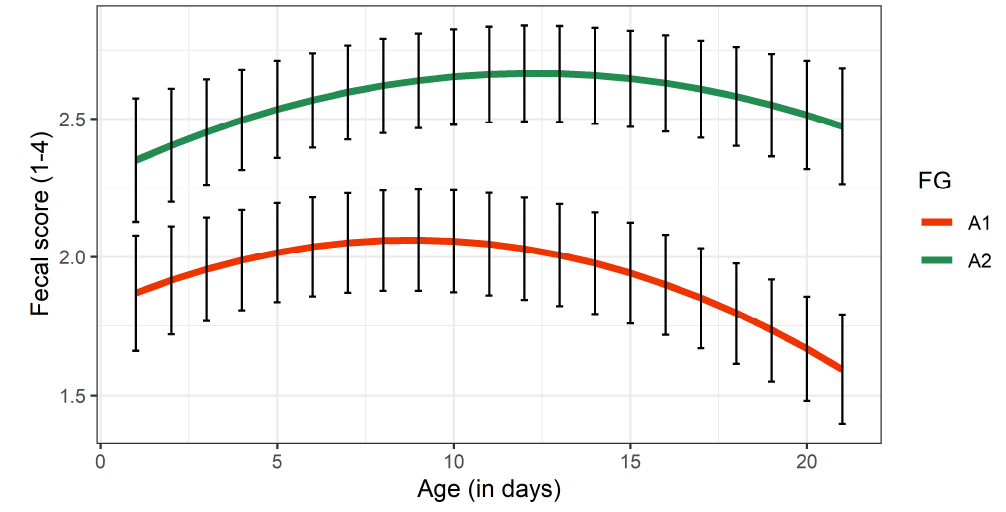
Figure 4. Least squares means for fecal scores of calves receiving either A1- or A2 milk during the experimental period of 21 days. Black bars indicate standard errors. FG, feeding group.